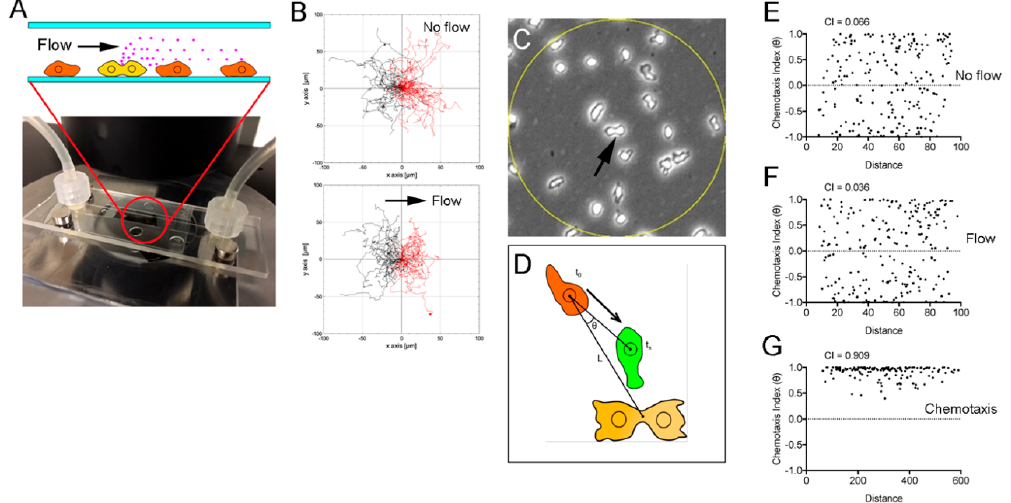
Figure 4. Midwife cells do not migrate toward a dividing cell chemotactically. ( A ) Cytokinesis D was examined in a microfluidic chamber with constant flow. If the medium constantly flows in one direction, a hypothetical unknown substance (red particles) secreted by dividing cells goes with the flow, and midwife cells migrate toward the dividing cell only from downstream locations. ( B ) Tracking of freely migrating cells without flow (upper panel) and with flow (lower panel). Note that the optimized flow did not a ff ect cell migration. ( C ) In the flow chamber, the CI was examined within the circle with a 100- µ m diameter (yellow circle) when the dividing cell was located at its center (arrow). ( D ) The CI was defined as the cosine of the angle consisting of three points: the initial position (red), the position of the furrow of the dividing cell (yellow), and the displaced position (green) after 3 min of cell migration. ( E ) Plots of the CI versus the distance of a cell from the dividing cell in the absence of flow (n = 212 cells, three independent experiments). ( F ) Plots of the CI versus the distance of a cell from the dividing cell in the presence of flow (n = 215 cells, three independent experiments). ( G ) Plots of the CI versus the distance of a cell from the aggregation center (n = 157). In this case, the CI was calculated from